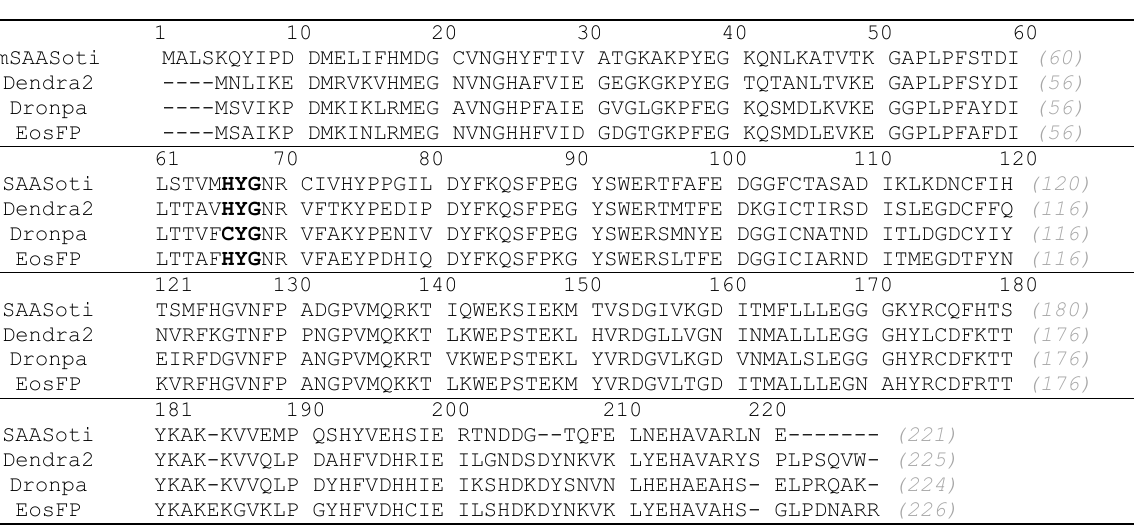
Figure 1. Multiple sequence alignment of mSAASoti with photoconvertible FPs. The numbering of all amino acid residues is given according to the SAASoti sequence. Site-directed mutagenesis was used to generate K145P, C21N/K145P, C21N/K145P/M163A, C21N/K145P/F177S, and C21N/K145P/M163A/F177S variants. After protein isolation and purification, we characterized their physicochemical properties and kinetic parameters in the reactions of photoconversion and photoswitching. K145P mSAASoti had the maximum value of the extinction coefficient (ε) for the green form; the bright lemon green color was observed directly after the centrifugation of E. coli cells expressing K145P mSAASoti. The C21N/K145P mSAASoti variant had mini- mal differences in physicochemical properties in comparison to K145P mSAASoti (Table 1). Table 1. Fluorescent characteristics of mSAASoti and its mutant forms. Green Mutant Form Form